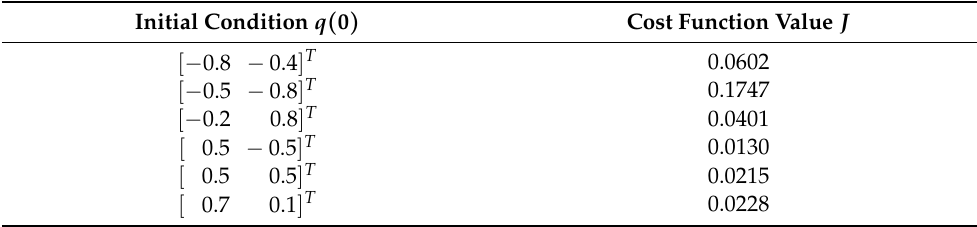
Table 3. The cost function values J of the proposed GCC design methodology by exchanging A 1 and A 2 in Example